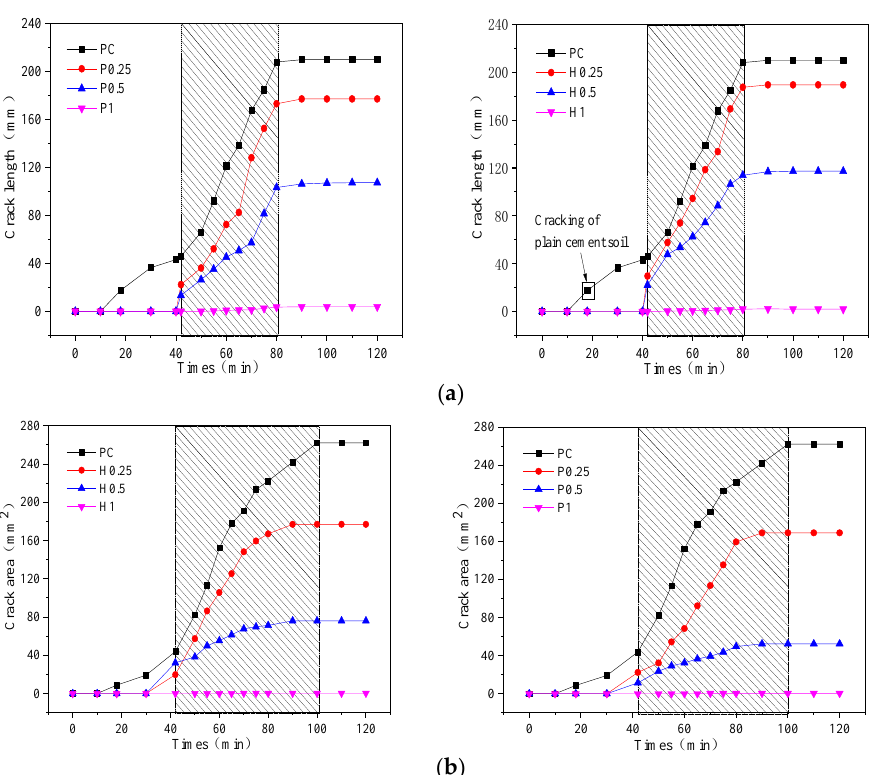
Figure 9. Quantitative results of desiccation crack: ( a ) curve of the crack length versus time; ( b ) curve of the crack area